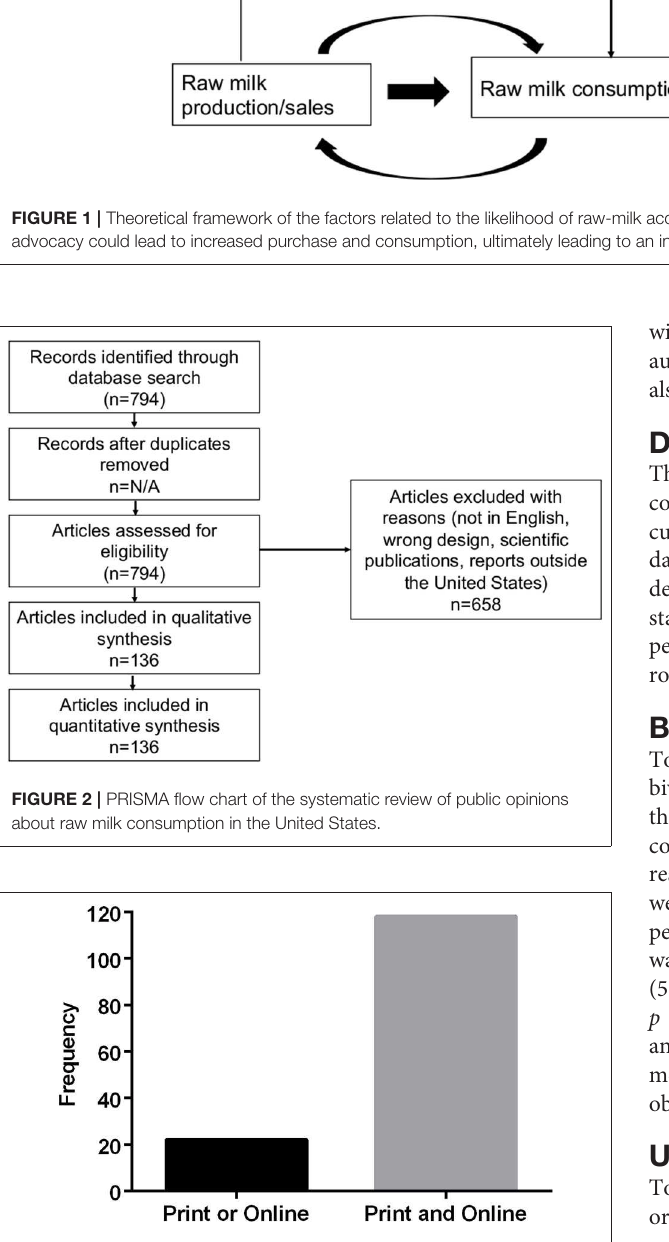
FIGURE 3 | Accessibility of the public to the varying information sources that support or are against the consumption of raw